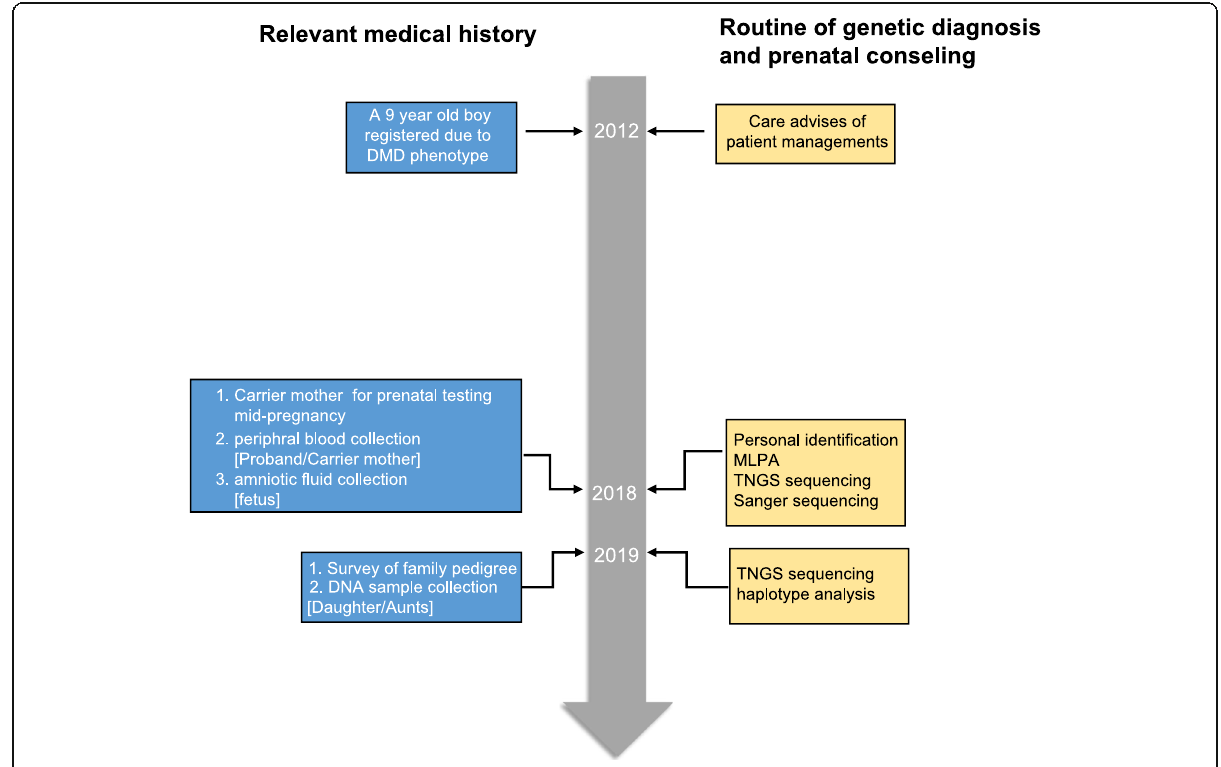
Fig. 1 Summary of the timeline of information reported in this